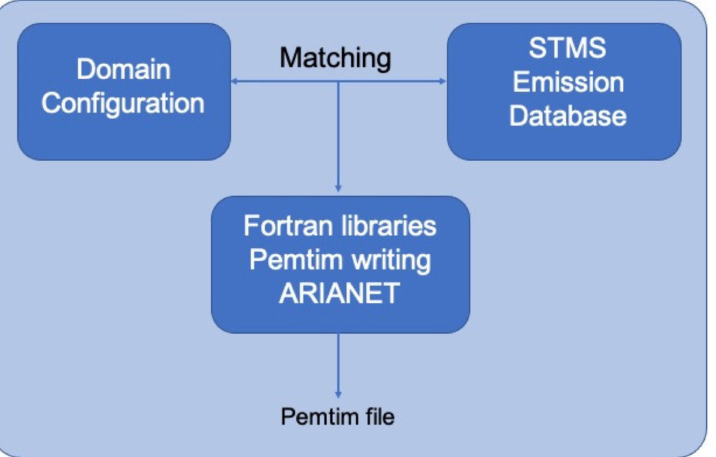
Figure A1. Scheme to illustrate the steps to create the files to use as input into